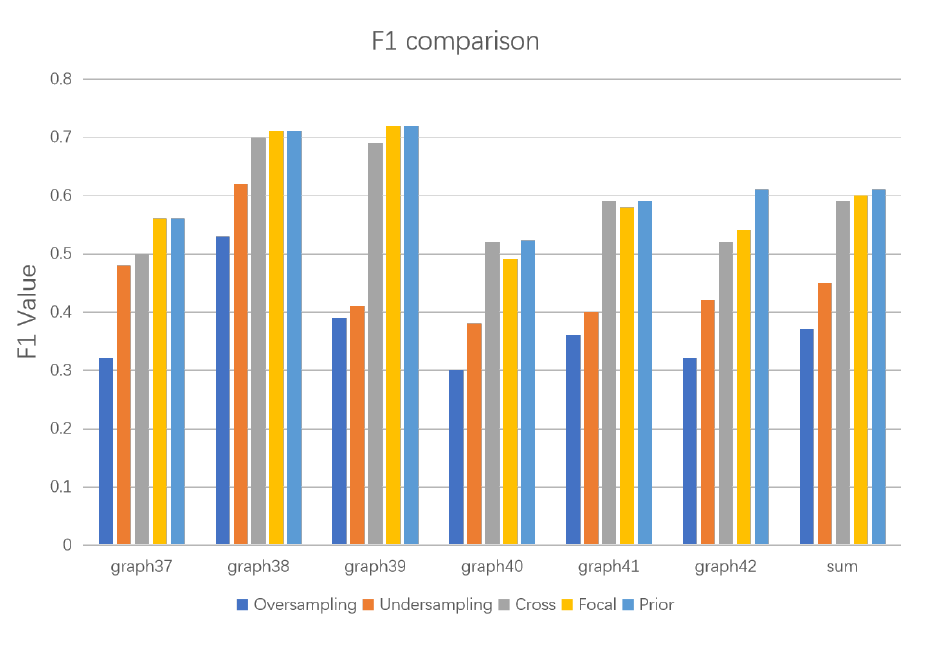
Figure 3. F1 score of different loss functions.